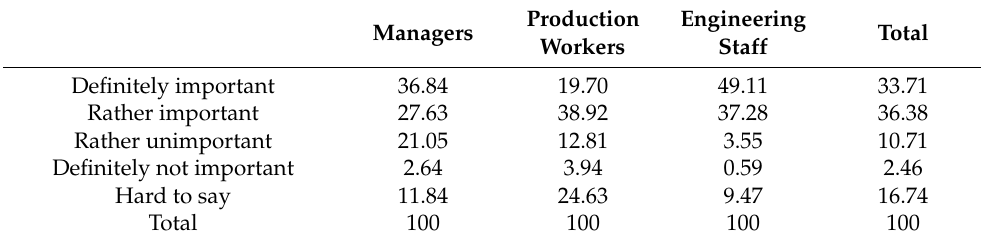
Table 6. Importance of acquiring new competences vs. position in % (N =